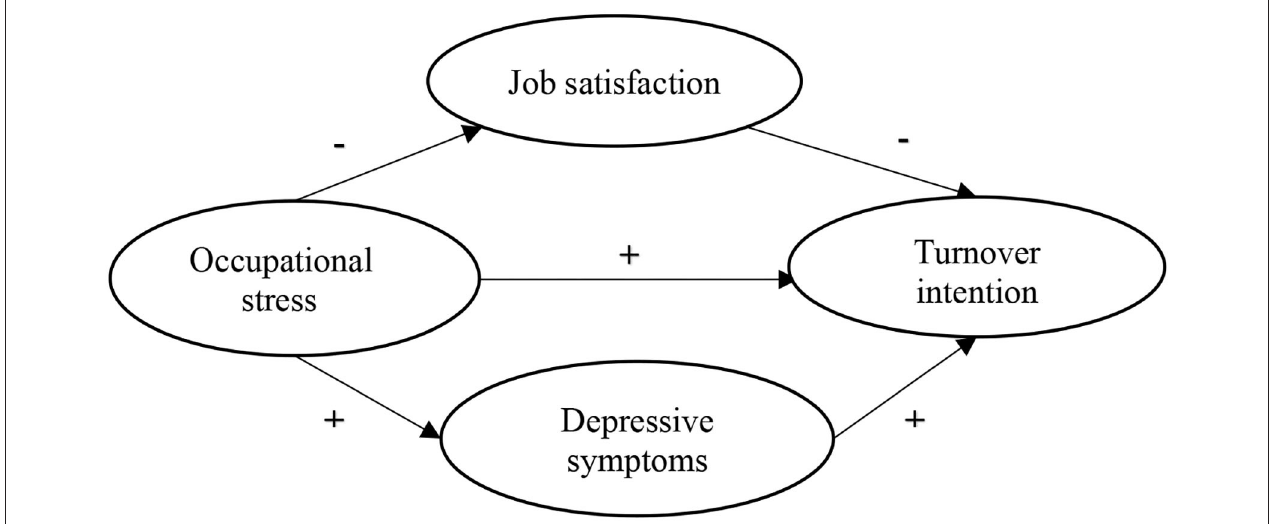
FIGURE 1 | The hypothesized structural model of turnover intention in Chinese emergency